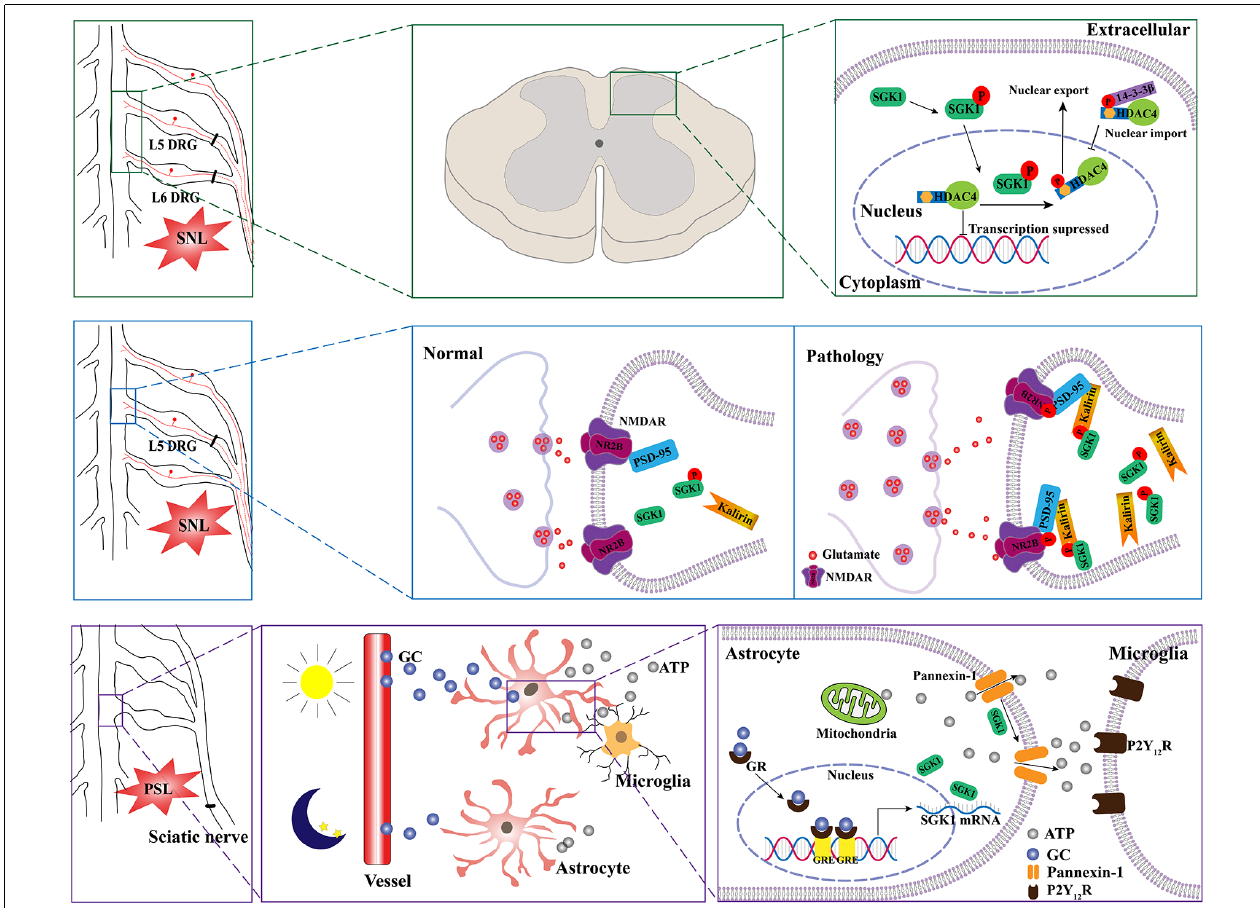
FIGURE 3 | Schematic illustration of potential mechanisms of SGK1 underlying the development of neuropathic pain. SNL induces the phosphorylation of SGK1. The activation of SGK1 promotes HDAC4 phosphorylation and export from nucleus to cytoplasm by 14-3-3, which restricts HDAC4 to the cytoplasm. Therefore, the decreased inhibition of nociception-associated gene expression by HDAC4 might contribute to SNL-induced allodynia (the upper panel). The upregulation of phosphorylated SGK1 in the SNL model enhances the expression of kalirin, which provokes the phosphorylation of PSD-95 coupling NR2B subunit, resulting in the increase of glutamatergic neurotransmission (the middle panel). Diurnal alterations in pain hypersensitivity result from diurnal variations in glucocorticoid levels. The increase in glucocorticoid levels induces an upregulation of SGK1 expression in spinal astrocytes and enhances extracellular ATP release by opening pannexin-1 hemichannels. Thereafter, the released ATP binds to P2Y12 receptors and induces the activation of microglia (lower panel). SNL, spinal nerve ligation; SGK1, serum- and glucocorticoid-inducible kinase 1; HDAC4, histone deacetylase 4; P, phosphorylated; NMDAR, N-methyl-D-aspartate receptor; NR2B, N-methyl-D-aspartate receptor 2 B; PSD-95, postsynaptic density-95; PSL, partial sciatic nerve ligation; GC, glucocorticoid; GR, glucocorticoid receptor; GRE, glucocorticoid receptor responsive elements; P2Y 12 R, purinergic receptor